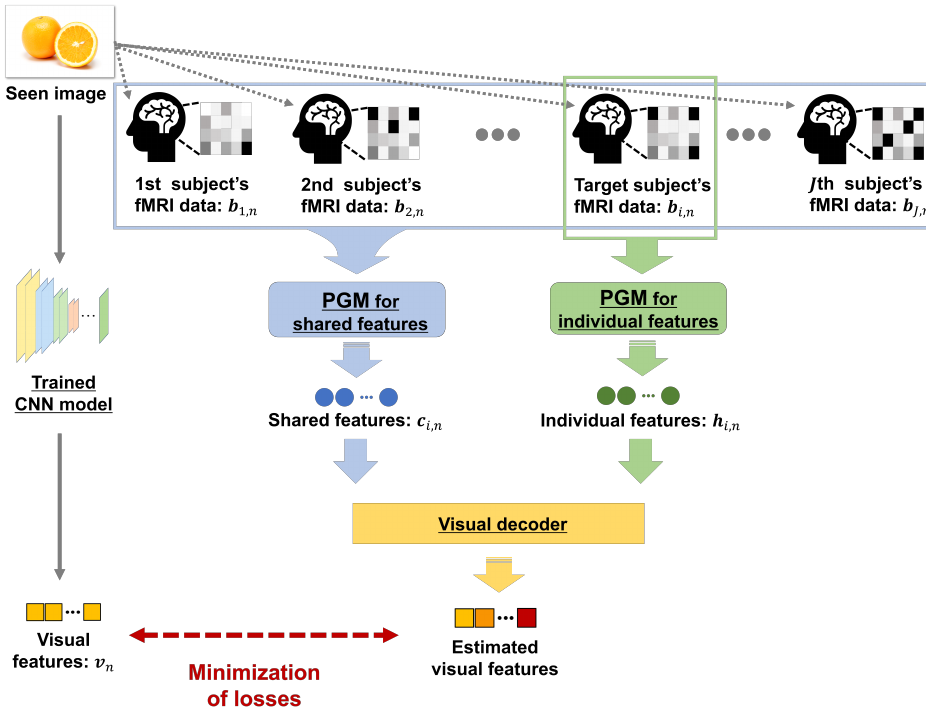
Figure 1. Overview of the training phase in the proposed method. Different PGMs are trained to extract shared and individual features of each subject. We can extract shared features from single- subject fMRI data. The PGM for individual features uses only single-subject fMRI data as a target for training. The visual decoder was trained using both extracted features from PGMs based on the minimization problem between the estimated and visual features from the trained